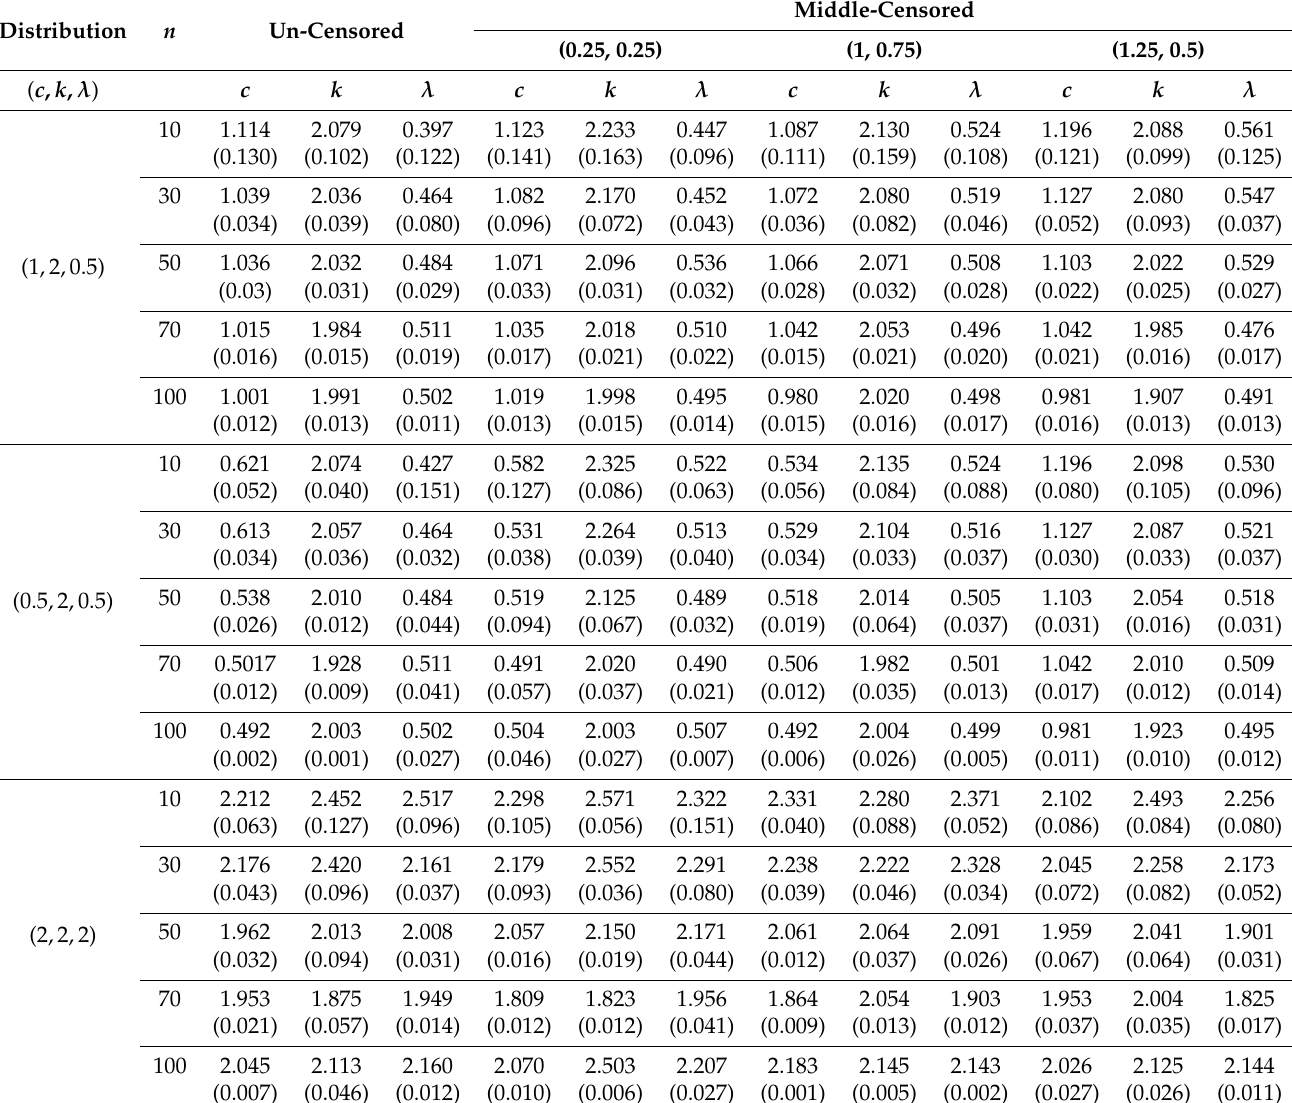
Table 3. Average MLE estimates and the corresponding MSE (within